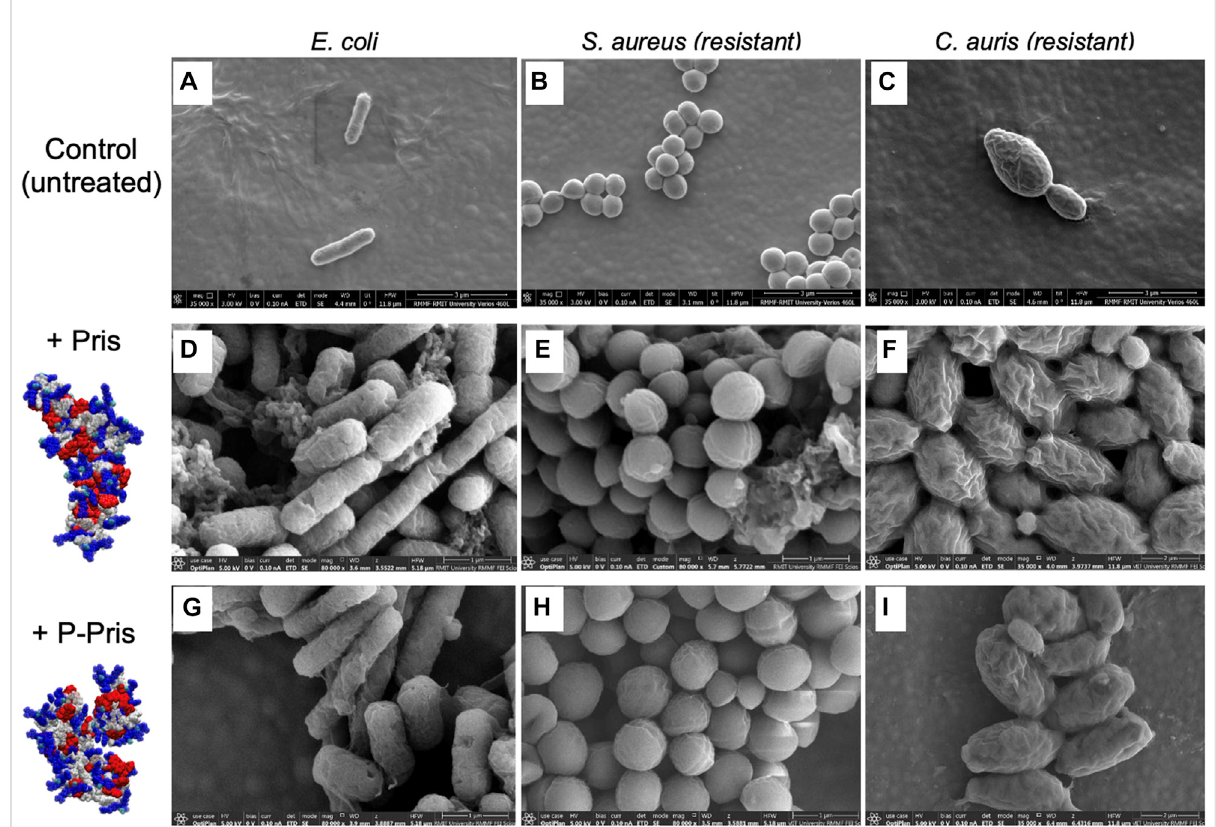
FIGURE 2 Representative scanning electron micrographs (SEM) of untreated (control, A – C ) and treated bacterial/fungal cells with Priscilicidin (D – F) and P-Priscilicidin (G – I) . Priscilicidin was added at 2.4 times MIC (D – F) and the peptide P-Priscilicidin at 1.2 times MIC (G – I) (other concentrations are shown in Supplementary Figures S17 –